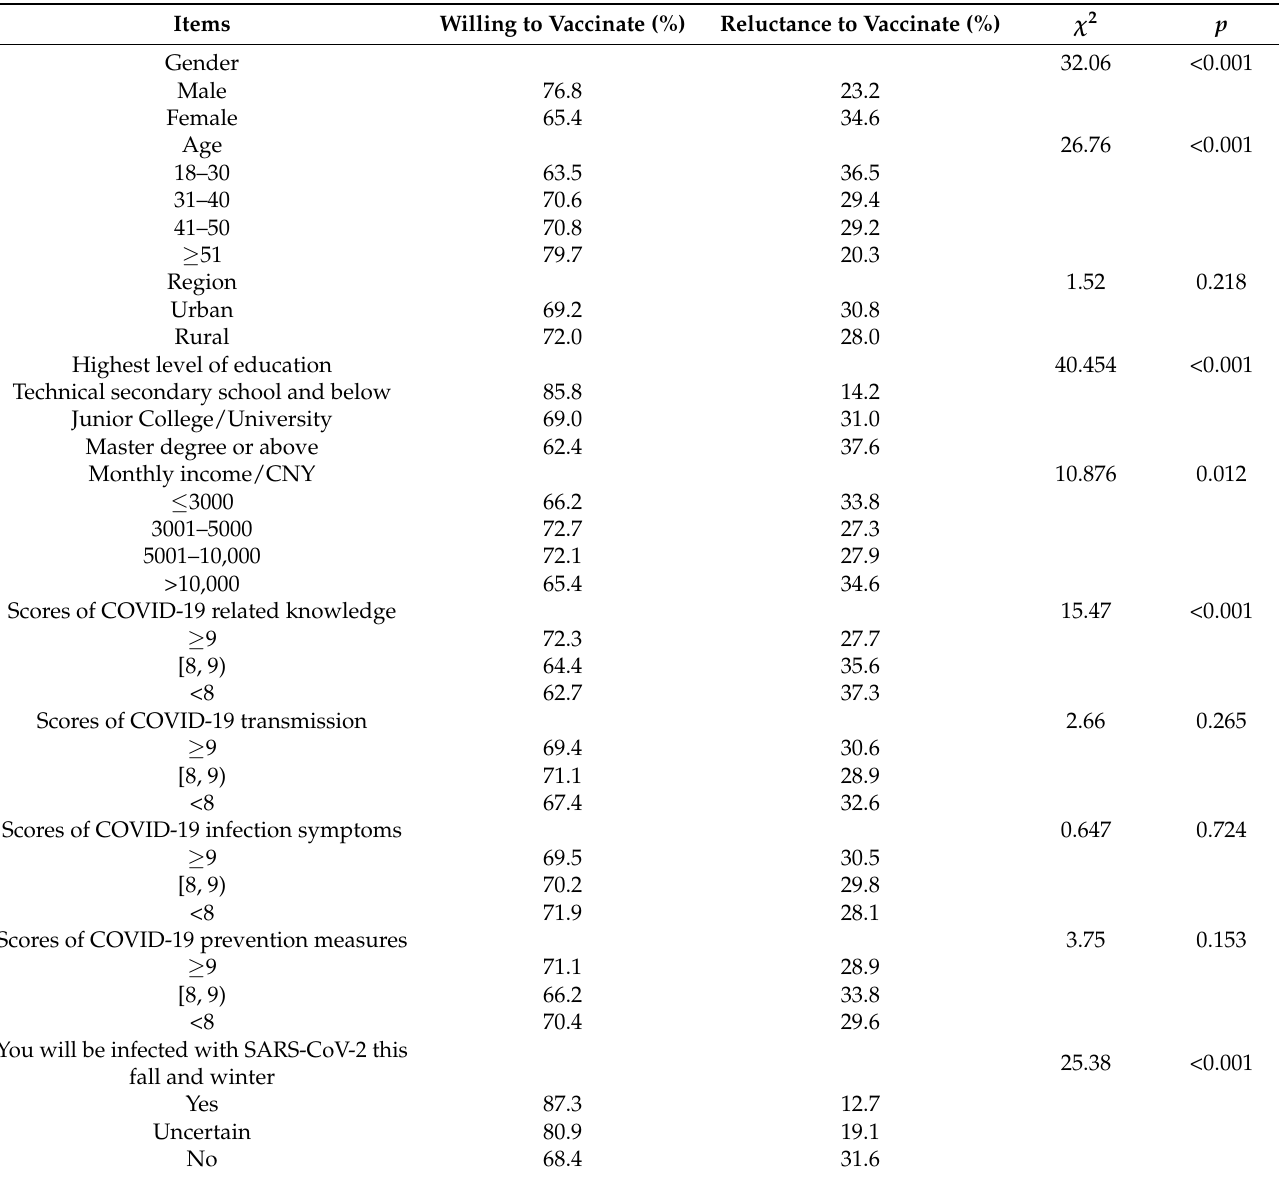
Table 6. Frequency distribution and chi-squared analysis of intentions of COVID-19 vaccination under